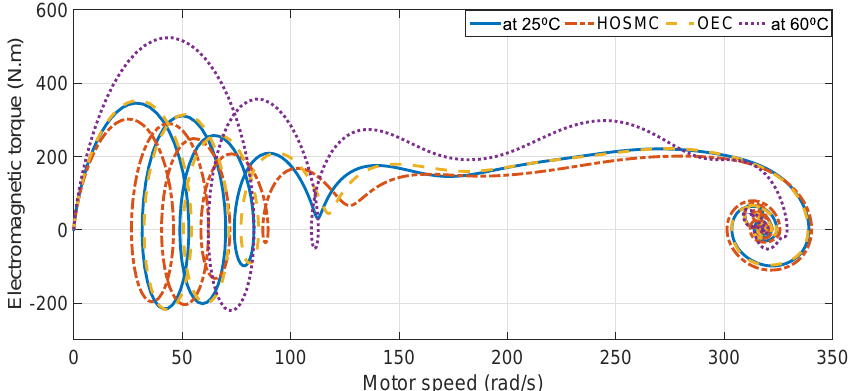
Figure 9. Comparison of motor dynamic behavior.